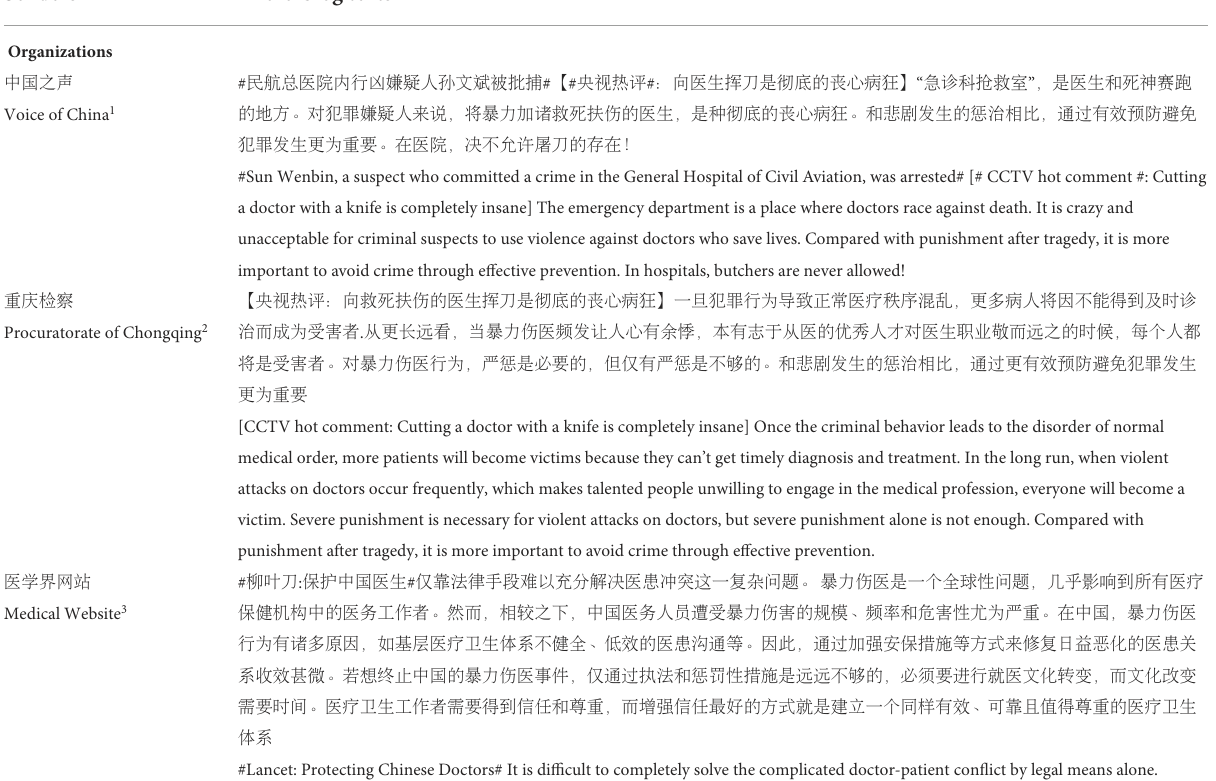
TABLE 3 Examples of micro-blogs A